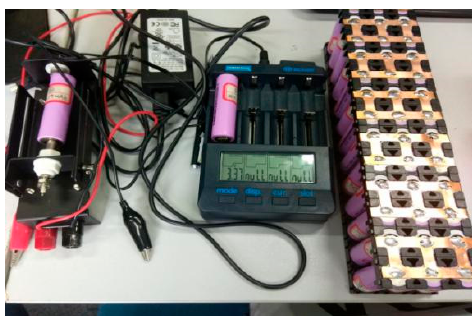
Figure 1. Experimental platform.